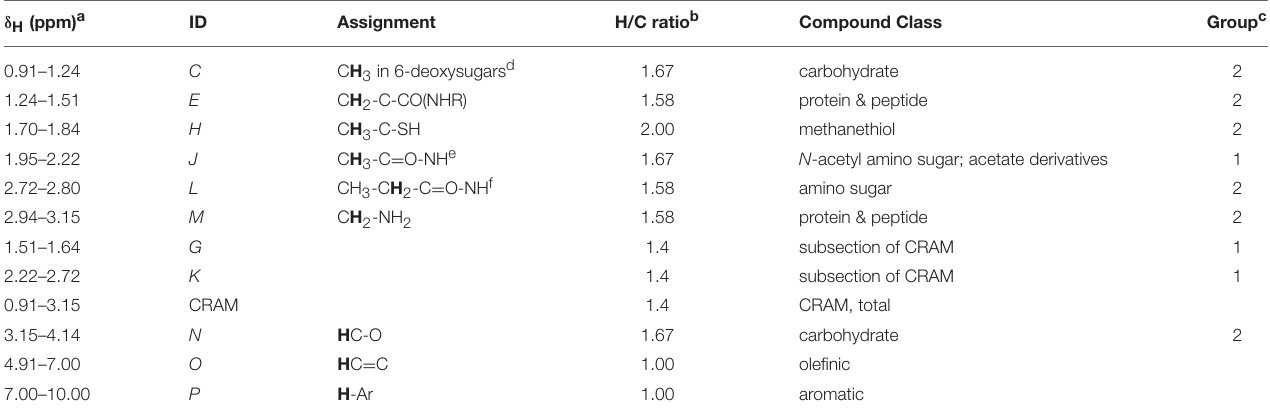
TABLE 2 | 1 H NMR peaks identified by 2D correlation